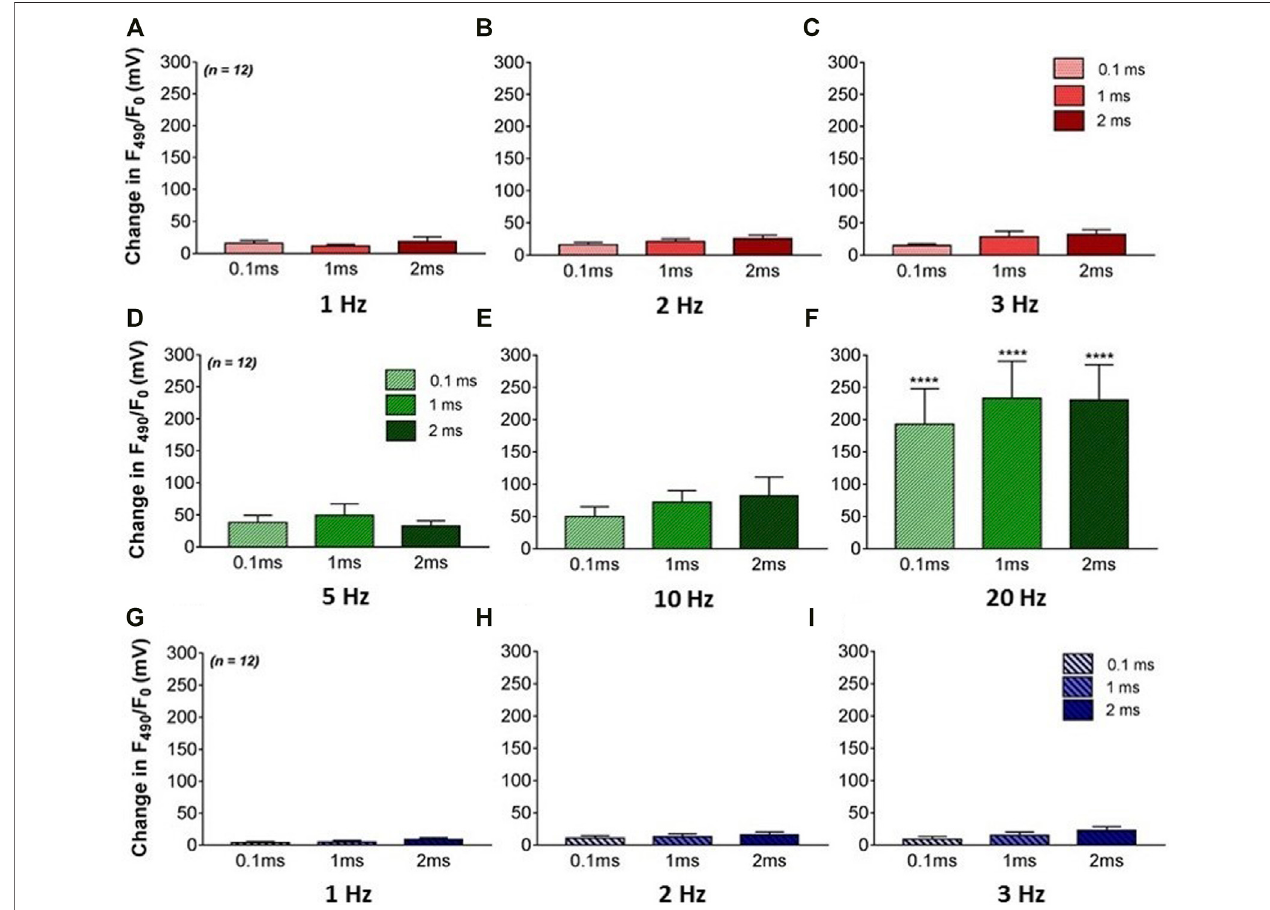
FIGURE3| TheeffectsofVNSonNOreleaseintheleftventricle. (A – C) MeanF490levelsduringhighvoltageandlowfrequencystimulationat1 (A) ,2 (B) and3 Hz (C) VNSat0.1,1,and2 mspulsewidths. (D – F) MeanF490levelsduringlowvoltageandhighfrequencystimulationat5 (D) ,10 (E) and20Hz (F) VNSat0.1,1,and2 ms pulsewidths. (G – I) MeanF490levelsduringlowvoltageandlowfrequencystimulationat1 (G) ,2 (H) and3 Hz (I) VNSat0.1,1,and2 mspulsewidths.Datarepresented as mean ± SEM. **** p < 0.0001 vs. corresponding BL n = 12.